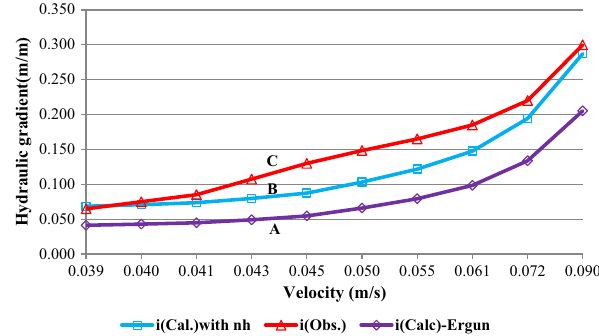
Fig. 9 Comparing plots of hydraulic gradient versus velocity for CGM1 series. Result is after 840 s of run start. Curve “A” shows vari- ations of ( i ) versus ( V ) based on common porosity concept, curve “B” shows variations of ( i ) versus ( V ) based on hydraulic porosity con- cept, curve “C” shows variations of ( i ) versus ( V ) based on actual model observations